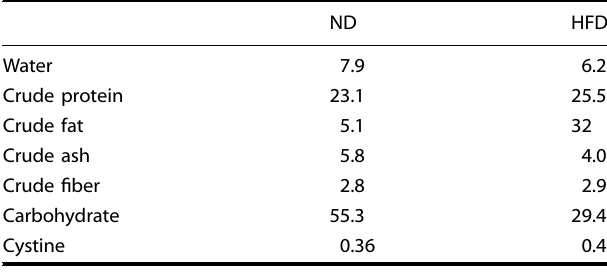
Table 2. Proximate composition and cystine content of animal diets